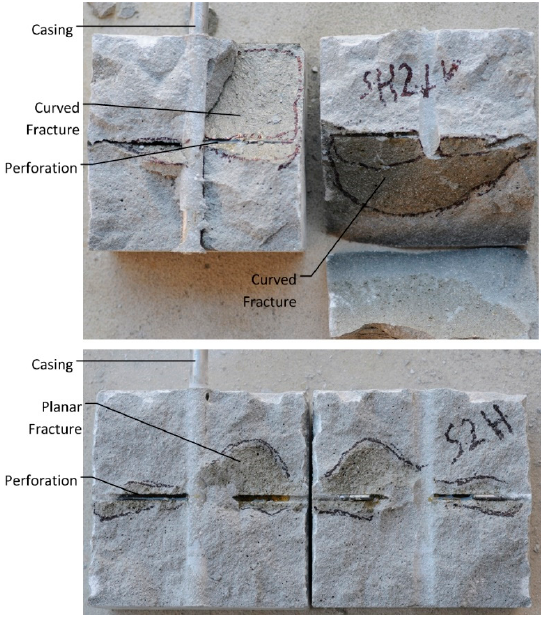
Figure 6. Test H-3 ( top ) and H-2 ( Bottom ) fracture geometries.